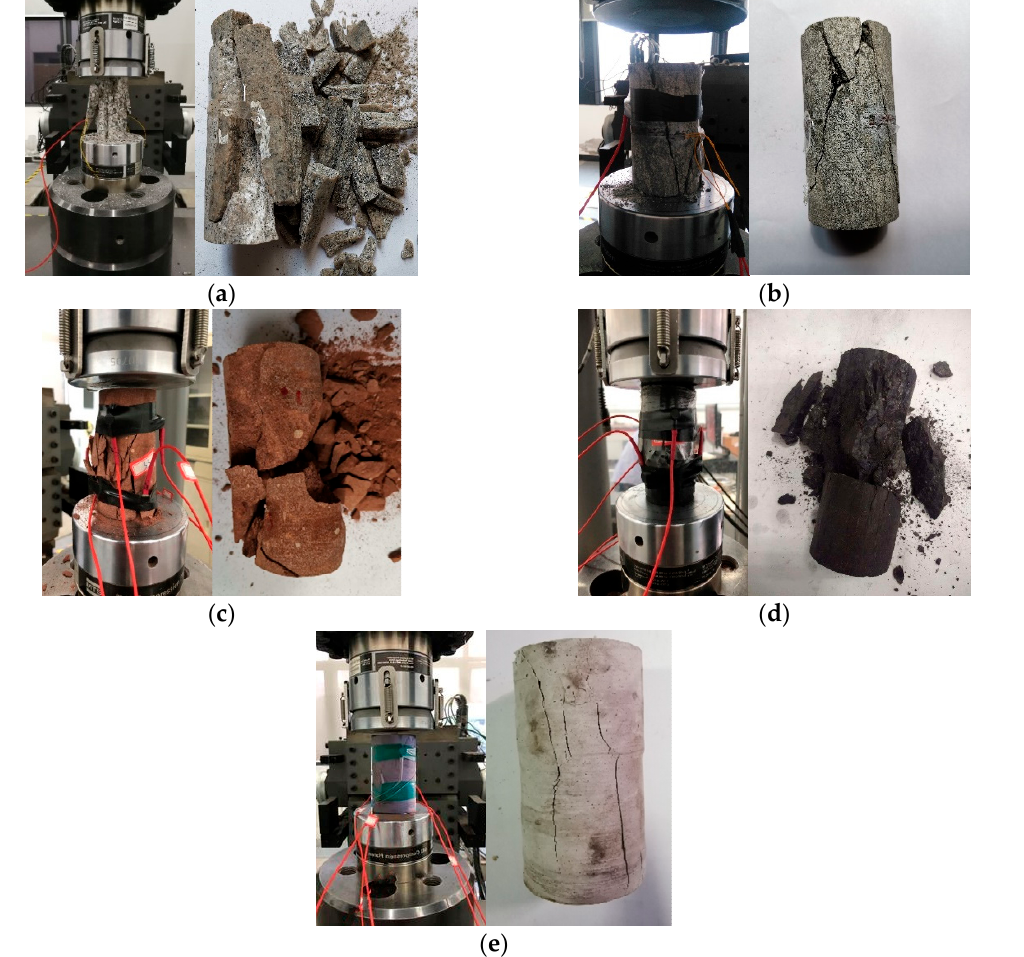
Figure 14. Failure mode of five rock materials. ( a ) Granite, ( b ) gypsum, ( c ) red sandstone, ( d ) coal, and ( e ) high-water material.